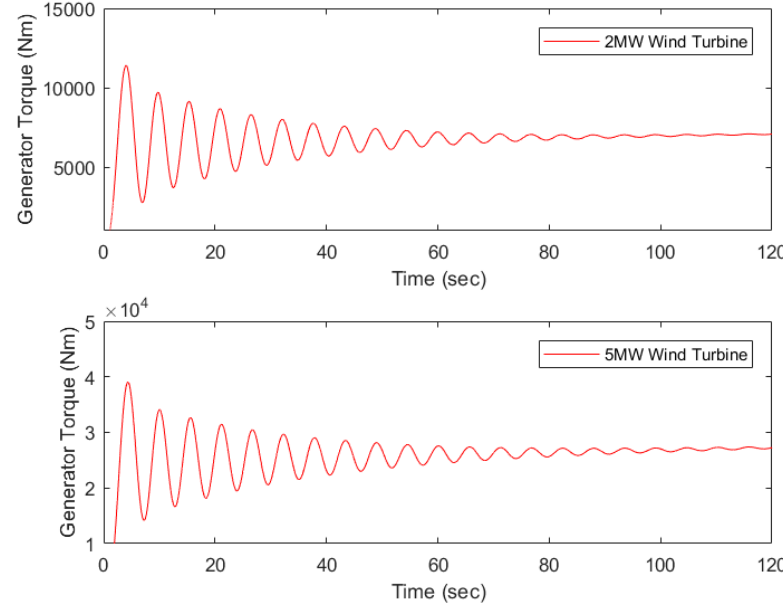
Figure 10. Generator torque control input u p ( t ) to the plant in regions one and two.